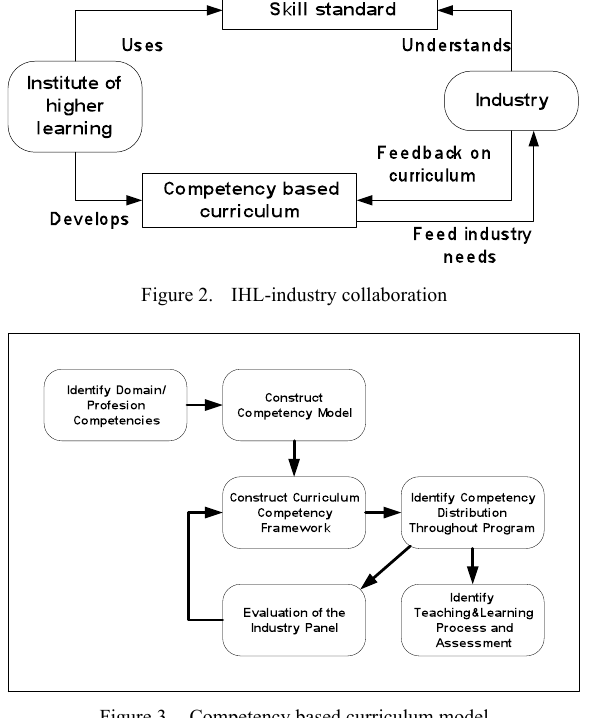
Figure 3. Competency based curriculum